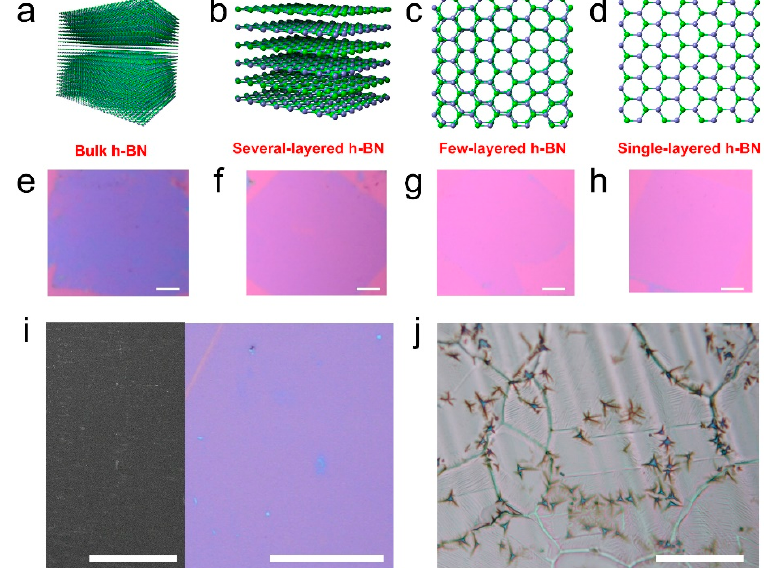
Figure 1. Optical images ( a – d ) and illustrations ( e – h ) of controllable growth of h-BN on Ni substrates for bulk ( a , e ), several layers ( b , f ), few layers ( c , g ) and a single layer ( d , h ) on SiO 2 . Scale bar in ( e – h ) is 2 mm. ( i ) SEM image of few-layered h-BN on Ni foil (left, scale bar 1 mm) and optical image of few-layered h-BN film on SiO 2 ( scale bar 100 µm). ( j ) Bulk h-BN domains on Ni foils. Scale bar: 100 µm.